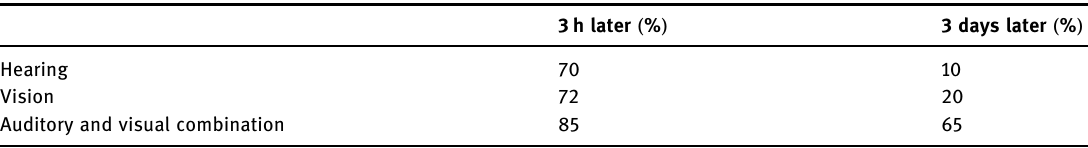
Table 1: Comparison of audiovisual memory of brand image